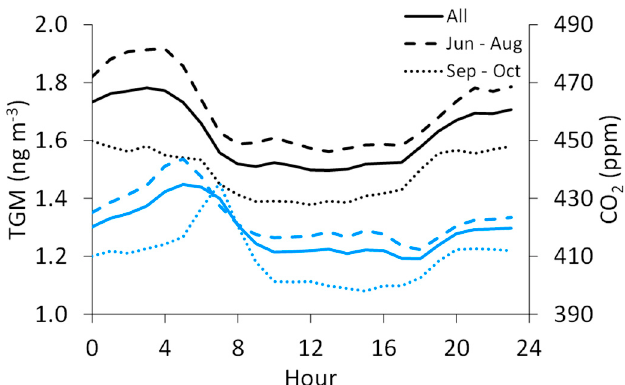
Figure 5. Diel patterns for TGM (black) and CO 2 (blue) for the full dataset (solid line), June through August (long dashed line), and September through October (short dashed line).